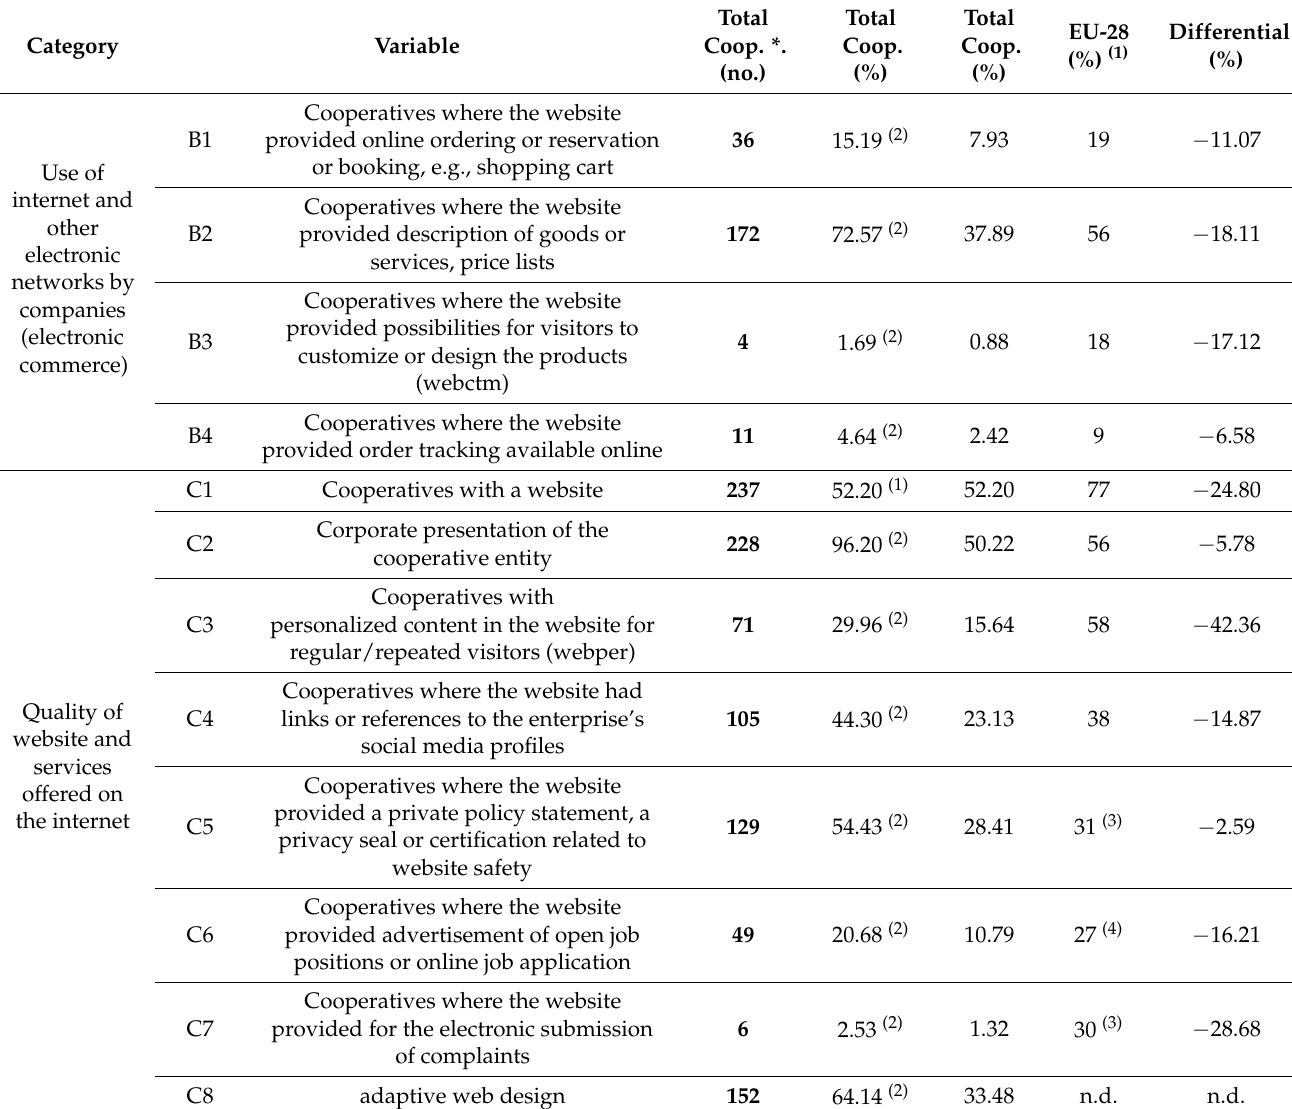
Table 3. EU agri-food cooperatives (28) 2018–2019: WEB services and electronic commerce (2019). Source: own development based on the data collected from the research, the community survey on ICT usage and e-commerce in enterprises (Eurostat, several